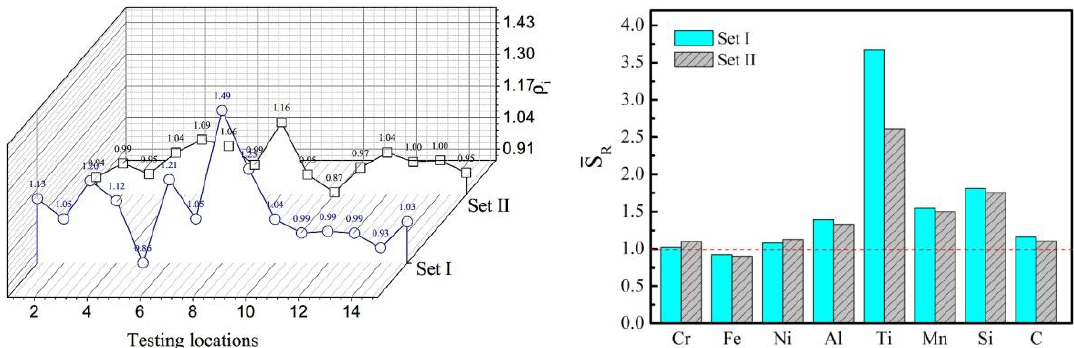
Figure 6. ( Left ) Variations of the content of carbon segregation index ρ i for different testing locations; ( Right ) Microsegregation ratio distribution without (set I) and with (set II) EMS.